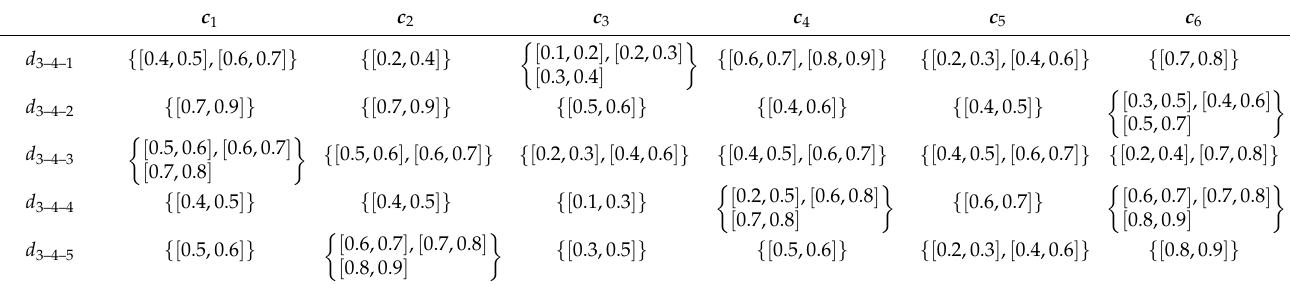
Table A17. Scoring matrix of business partner d 3–4